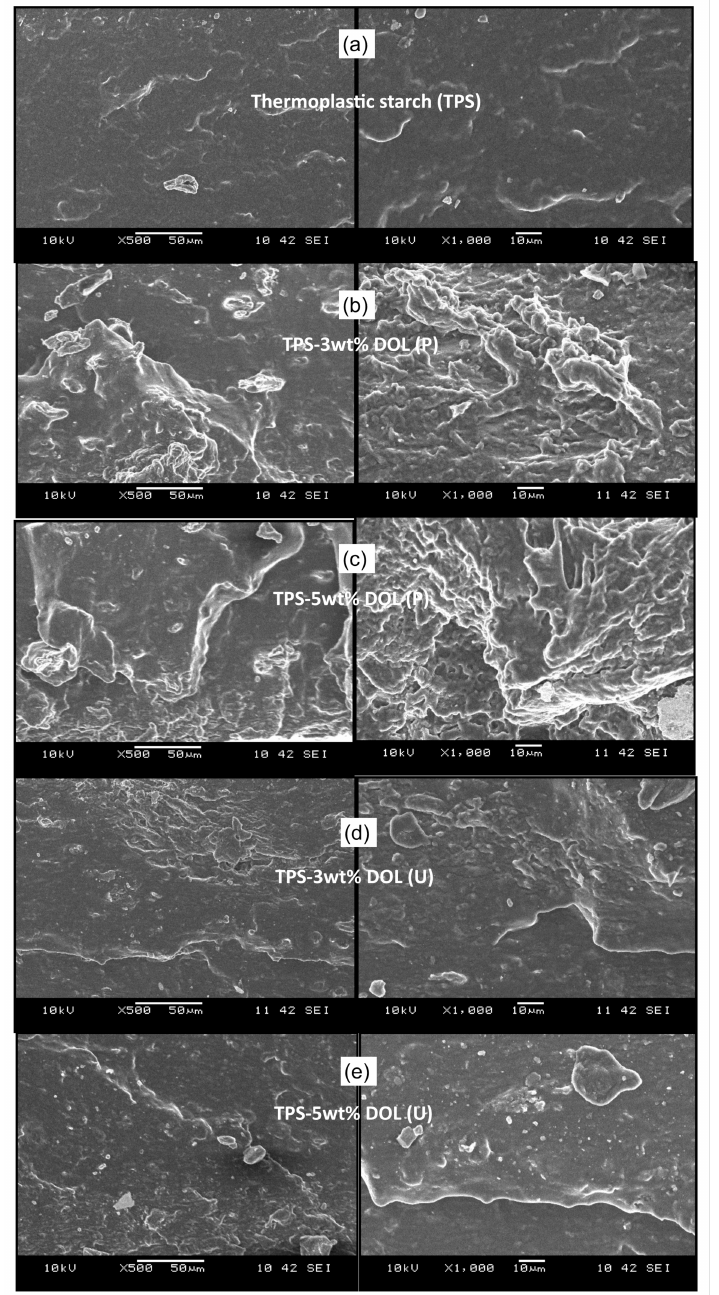
Figure 14. SEM images of tensile fractured surface of the ( a ) TPS film ( b ) TPS-3wt%DOL (P) ( c ) TPS-3wt%DOL (U) ( d ) TPS-5wt% DOL (P) and ( e ) TPS-5wt%DOL (U) biocomposite films at 500 × magnification (left) and 1000 × magnification